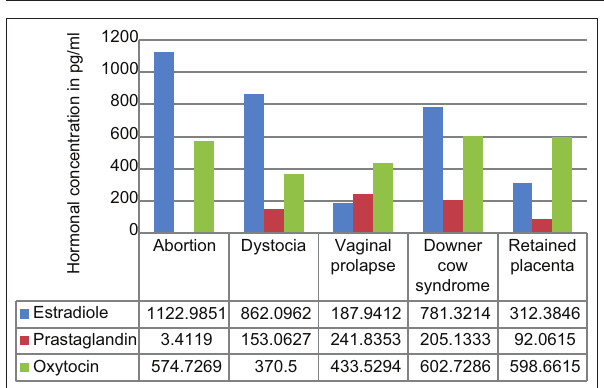
Figure-1: Concentrations of estradiol, prostaglandins, and oxytocin serum in cows with different reproductive conditions.